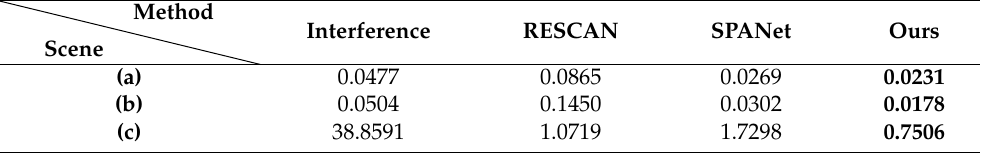
Figure 7. Visual results of simulation data. The first column gives the interfered SAR images and the second column gives the corresponding ground truth. The third to fifth columns give the results of the different methods. In addition, ( a – c ) indicate the different types of interference. Table 1. Comparisons of ∆ ENL for simulation data.